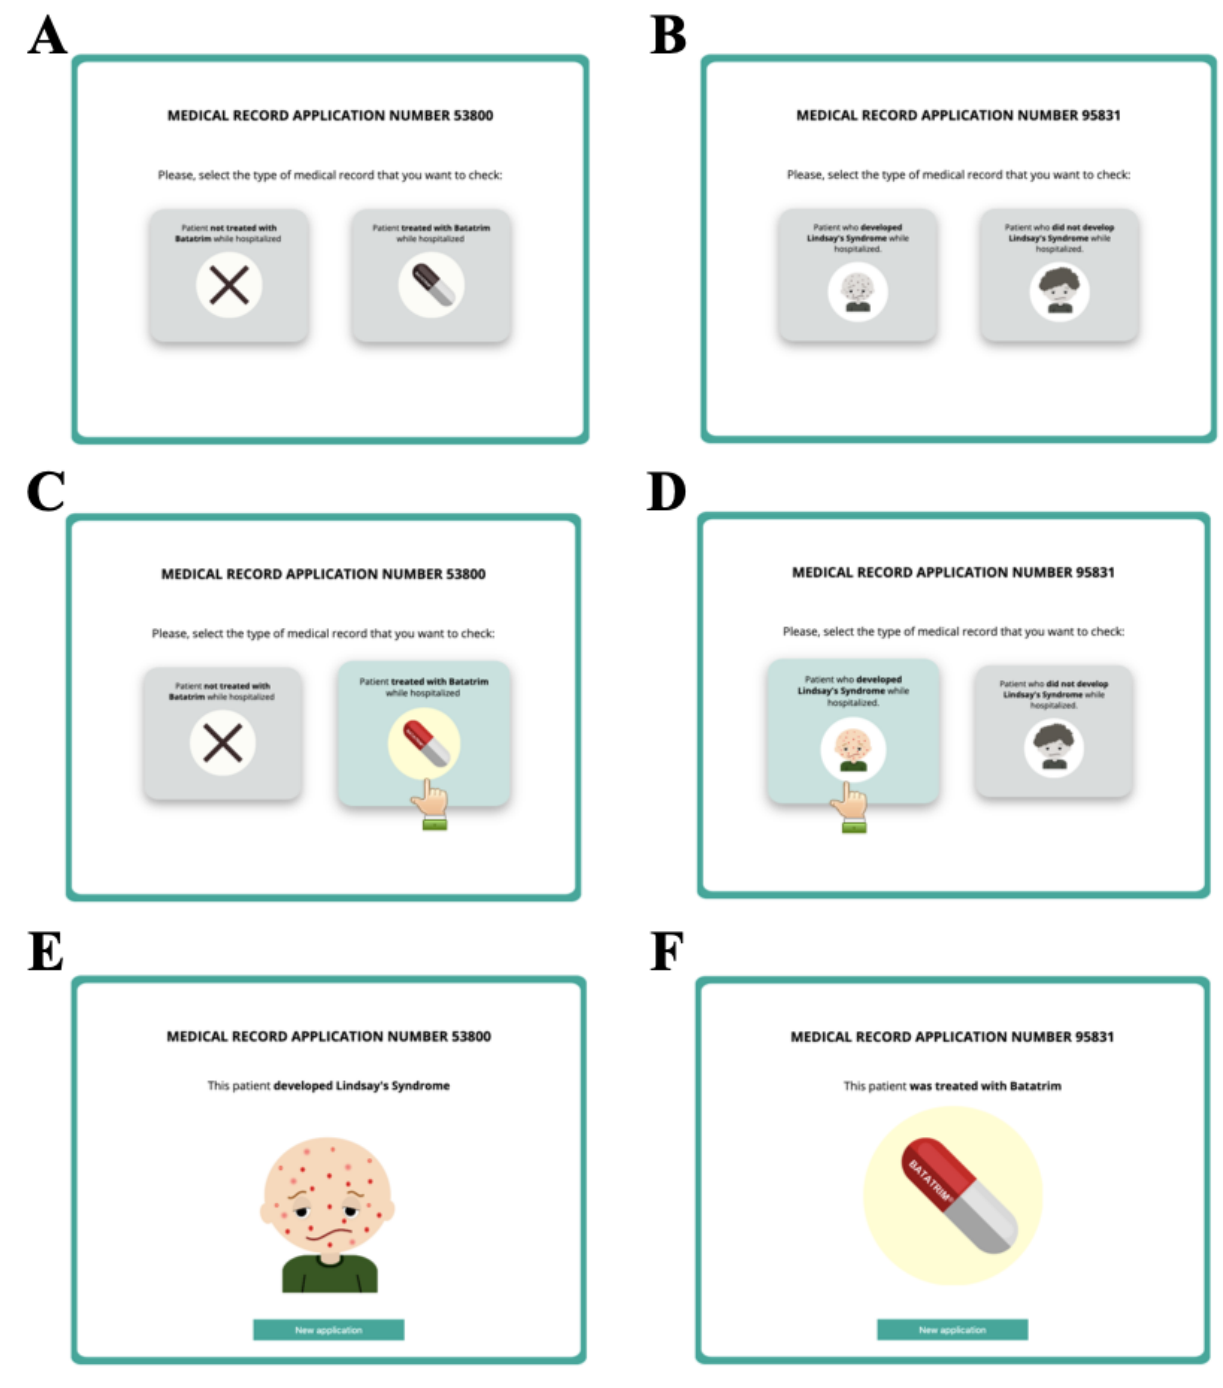
Figure 2. The sequence of events within a trial presented to the cause group (panels on the left) and to the effect group (panels on the